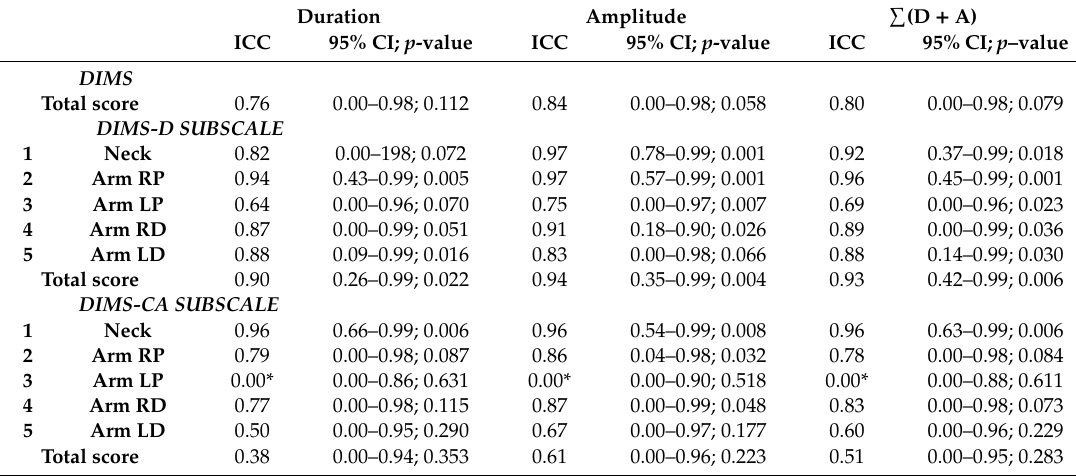
Table 3. Test-retest reliability: Intraclass Correlation Coe ffi cients (ICC) with 95% Confidence Interval (CI) between two measuring weeks for the Dyskinesia Impairment Mobility Scale (DIMS). Duration Amplitude